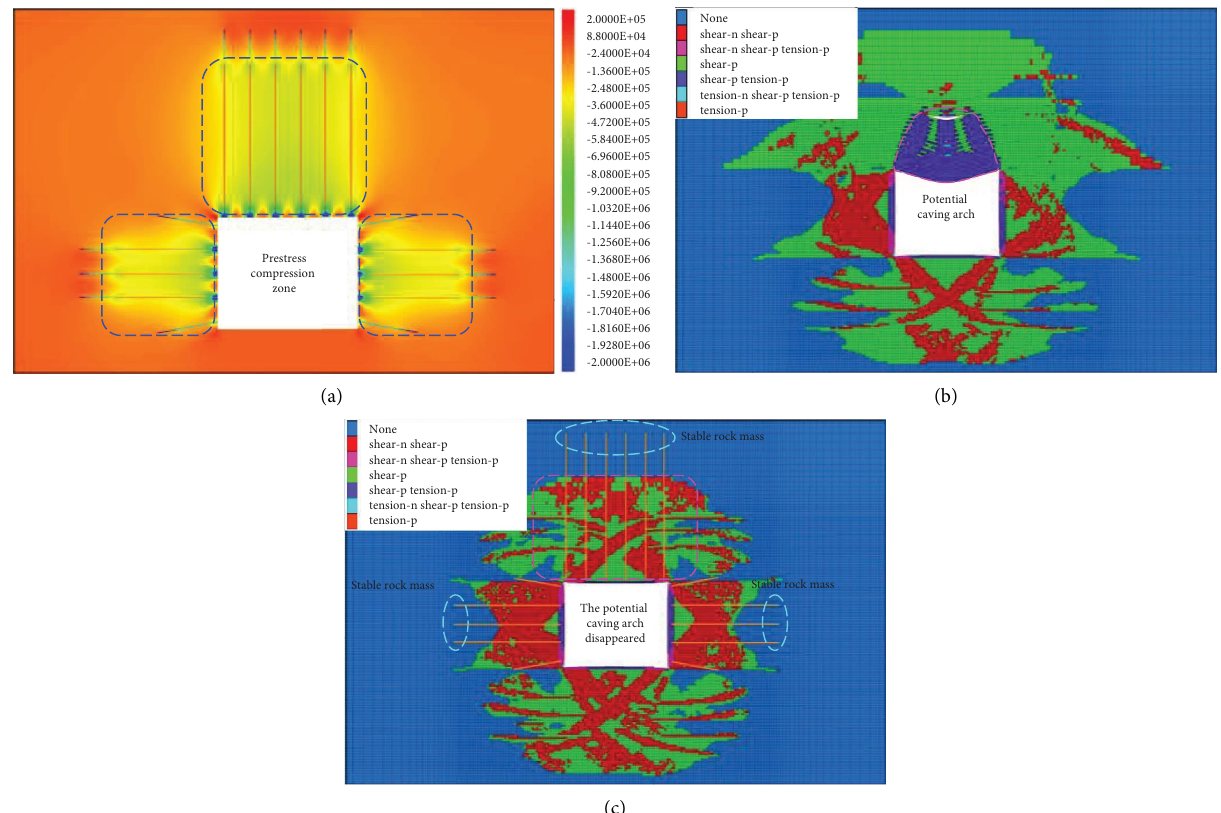
Figure 14: Numerical simulation results: (a) support stress feld; (b) unsupported roadway; (c) supported